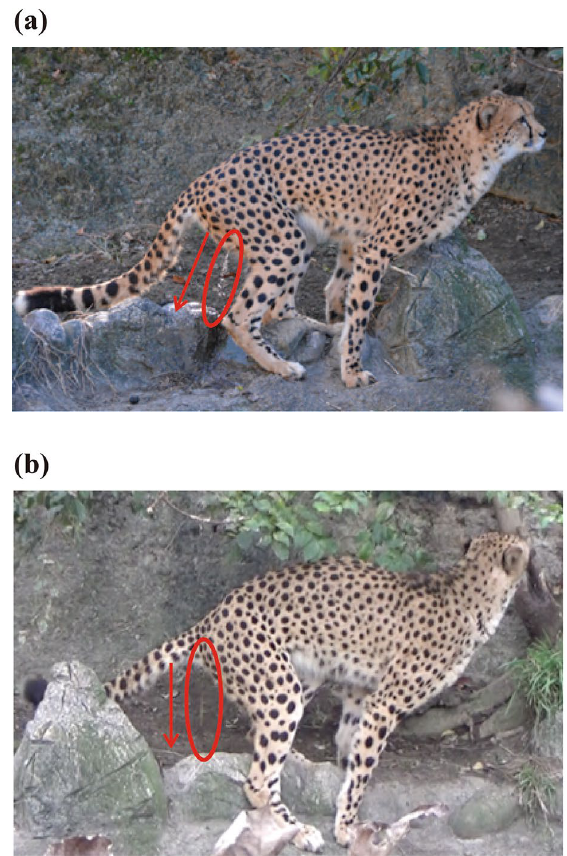
Figure 2. Comparison of postures when excreting urine and secretion during scraping behavior in captive cheetahs: ( a ) urination and ( b ) secretion discharge. The red arrows indicate the direction of release of the urine or secretion.